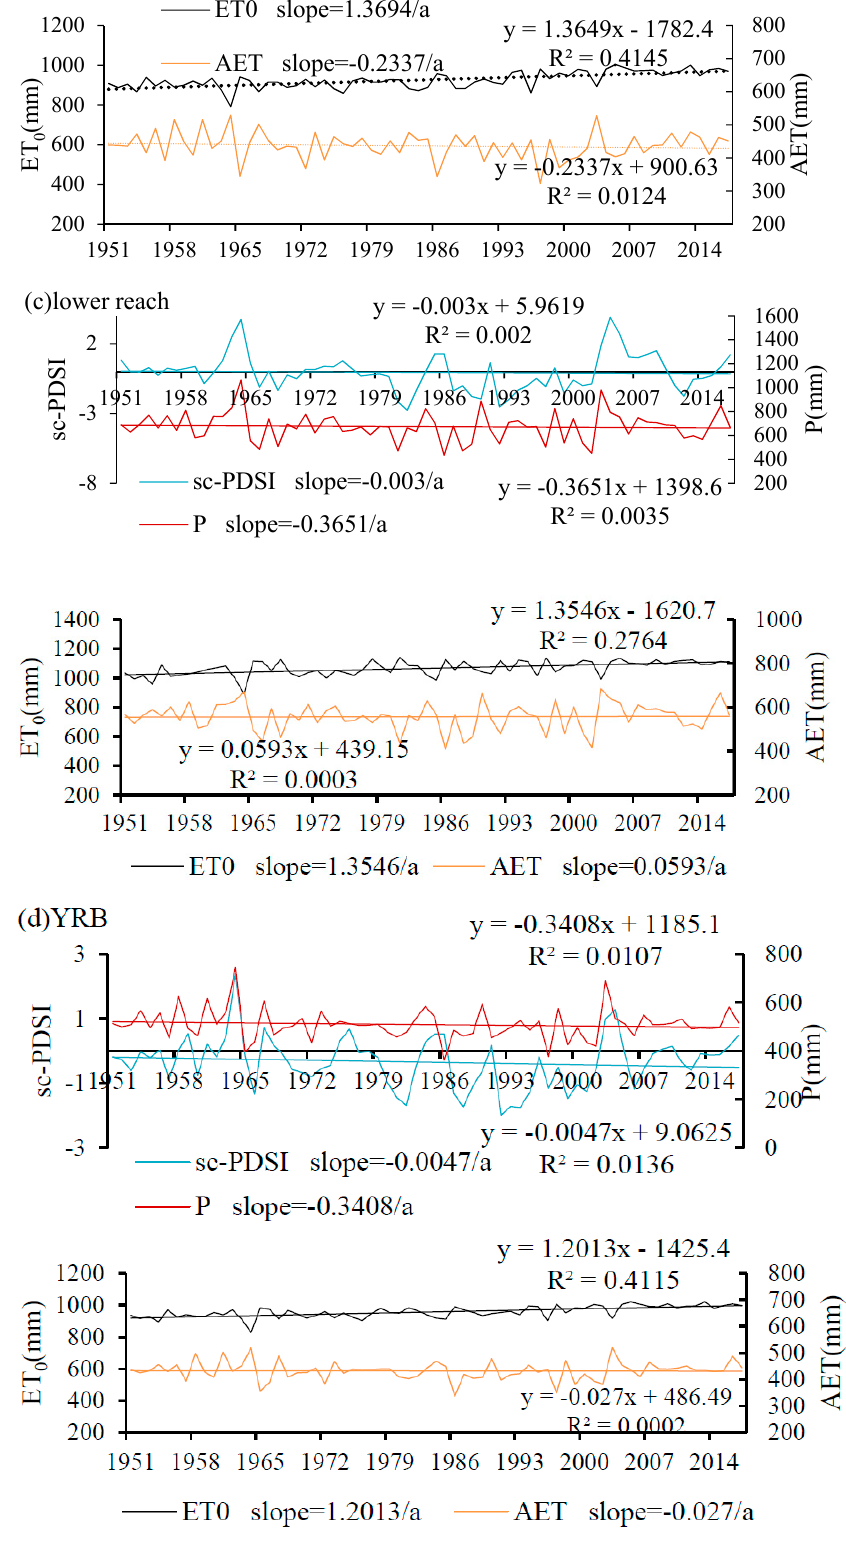
Figure 4. Annual variations of sc-PDSI, P, ET 0, and AET in the upper, middle, lower reach, and the whole basin from 1951 to 2017.